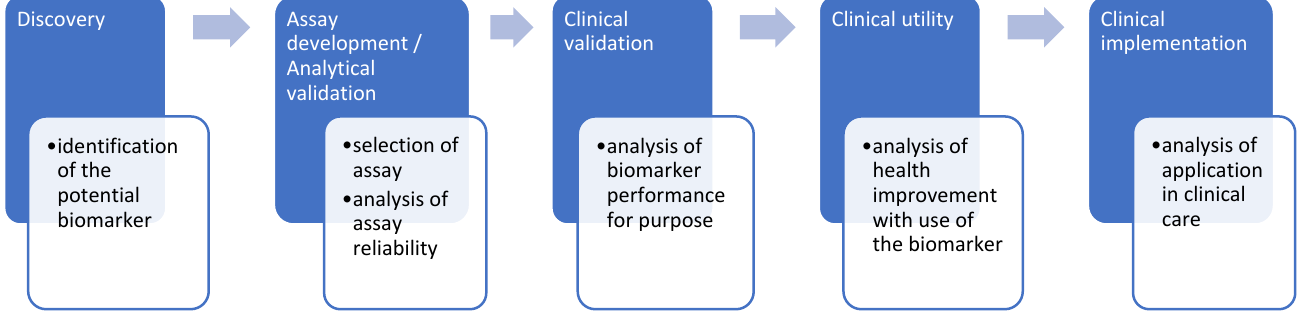
Figure 2. Schematic steps on the search for new biomarkers.